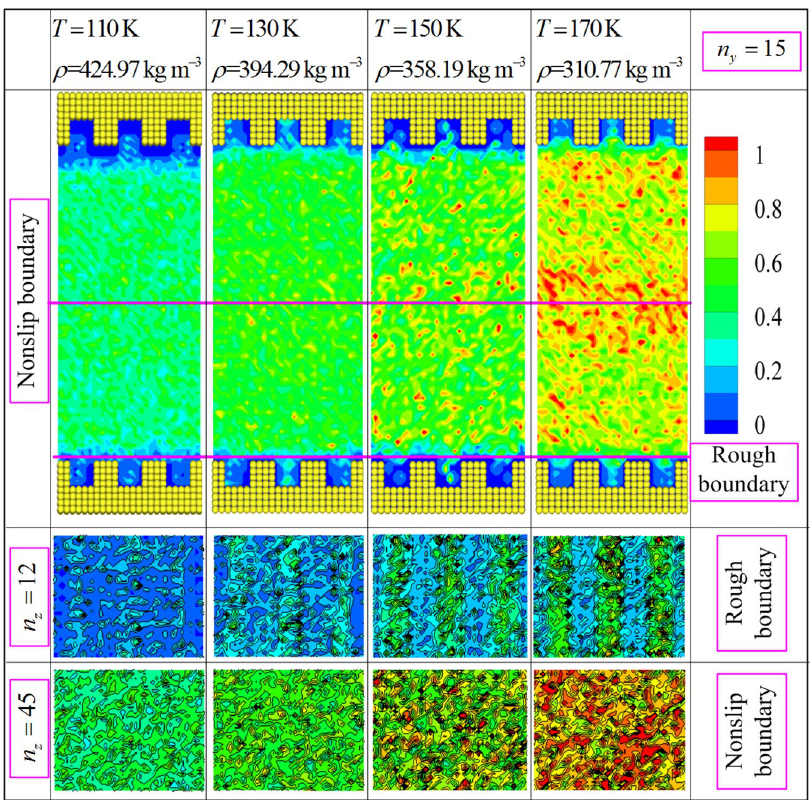
Figure 10. Rotational energy (the unit of energy is ε ) contour plots for different state points using the mixture boundary Poiseuille flow